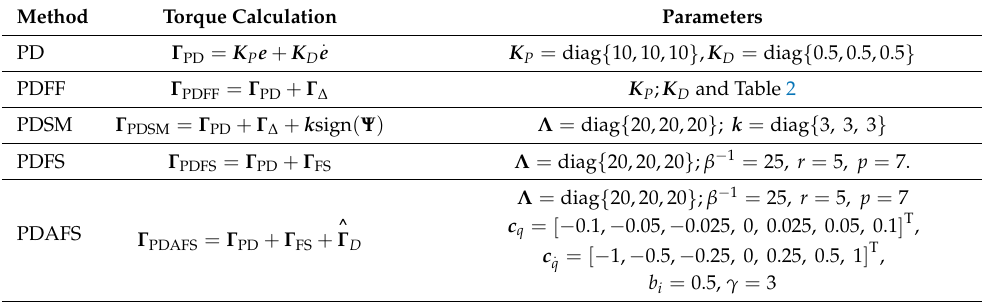
Table 8. The parameters of the proposed controller and compared controllers in the experiment. Method